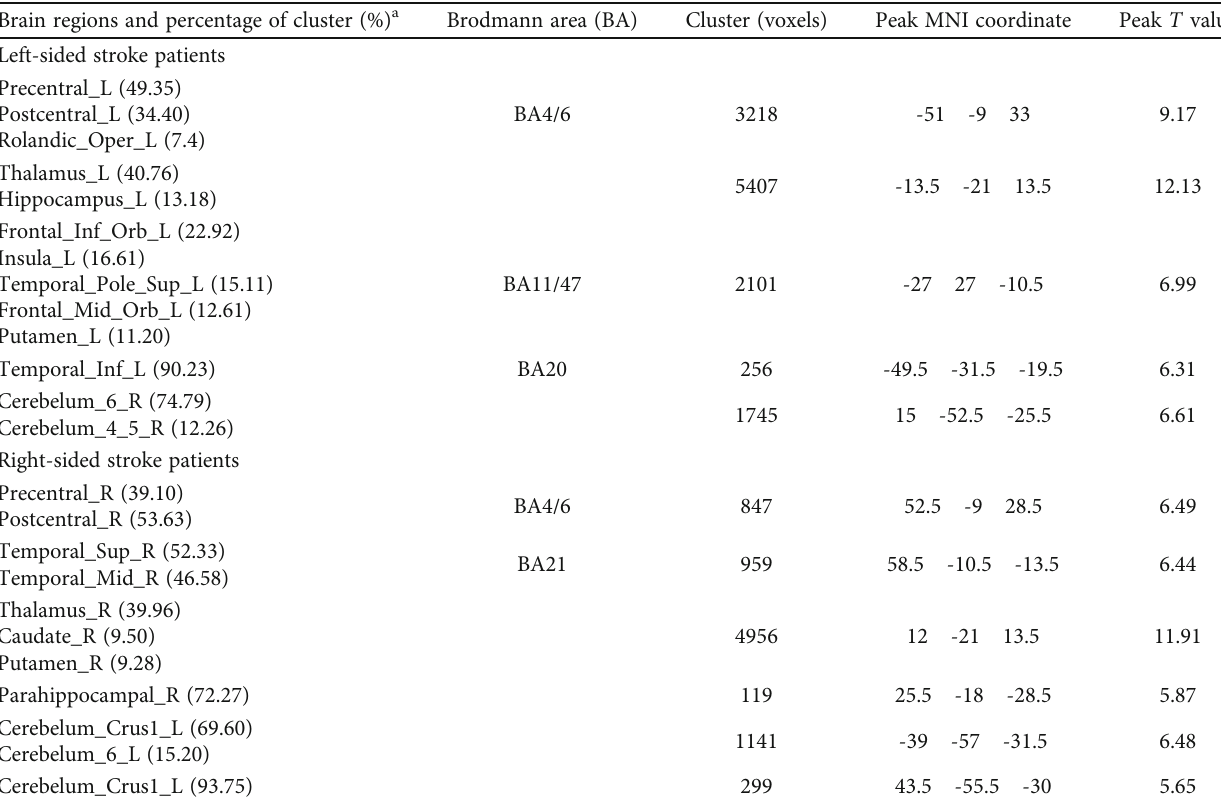
Table 2: Gray matter volume (GMV) di ff erences between stroke patients and healthy controls ( p < 0 : 05 , FWE corrected). Brain regions and percentage of cluster (%) a Brodmann area (BA) Cluster (voxels) Peak MNI coordinate Peak T